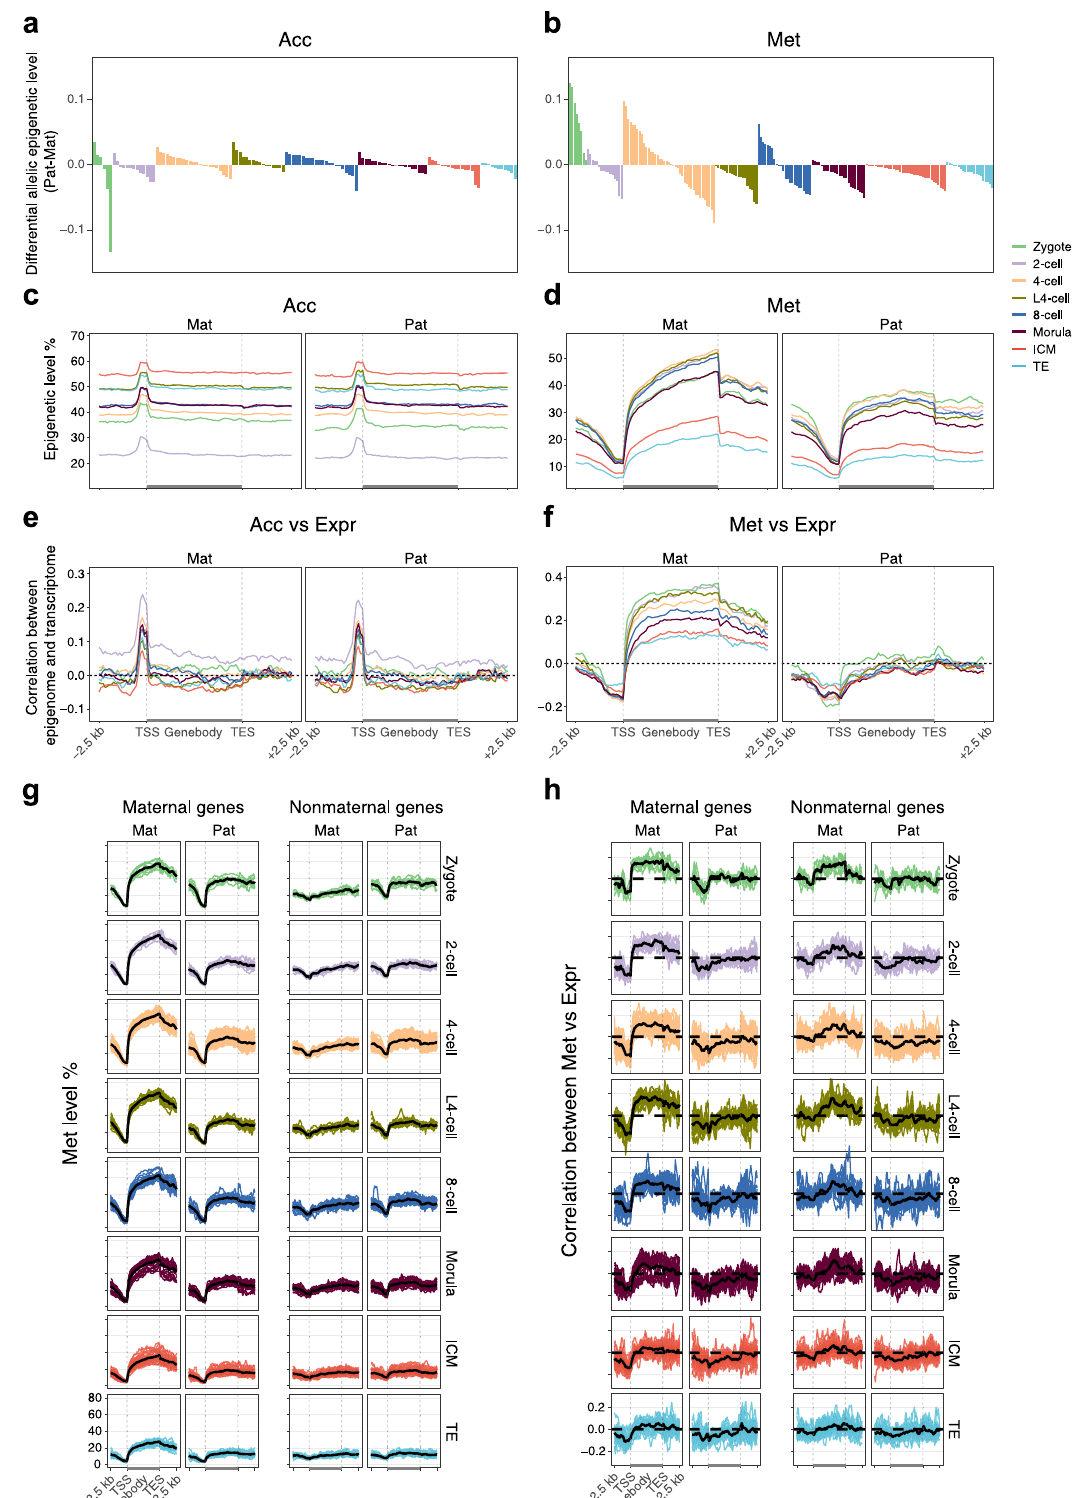
CRE-gene pairs (27 positive vs 324 negative pairs in promoters; 1,119 positive vs 4,194 negative pairs in distal regions) for the positively correlated Acc/Expr CREs, while we observed mainly positively correlated Met vs Expr CRE-gene pairs (105 positive vs 15 negative pairs in promoters; 1,504 positive vs 388 negative